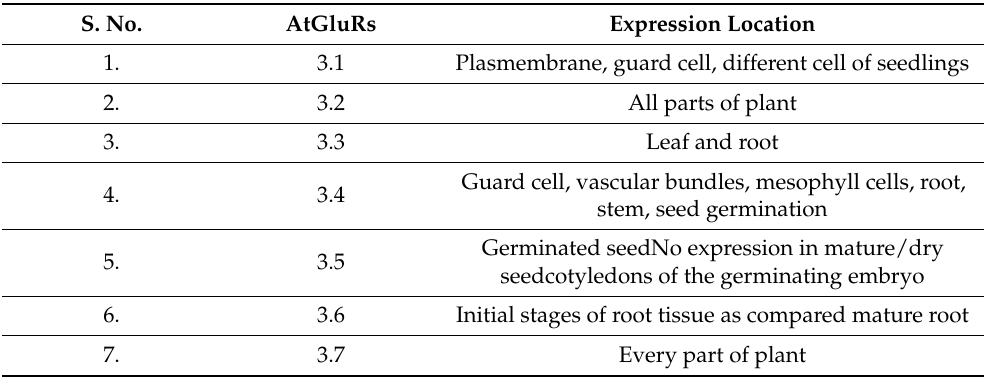
Table 2. The expression of Clade III genes in Arabidopsis . S.